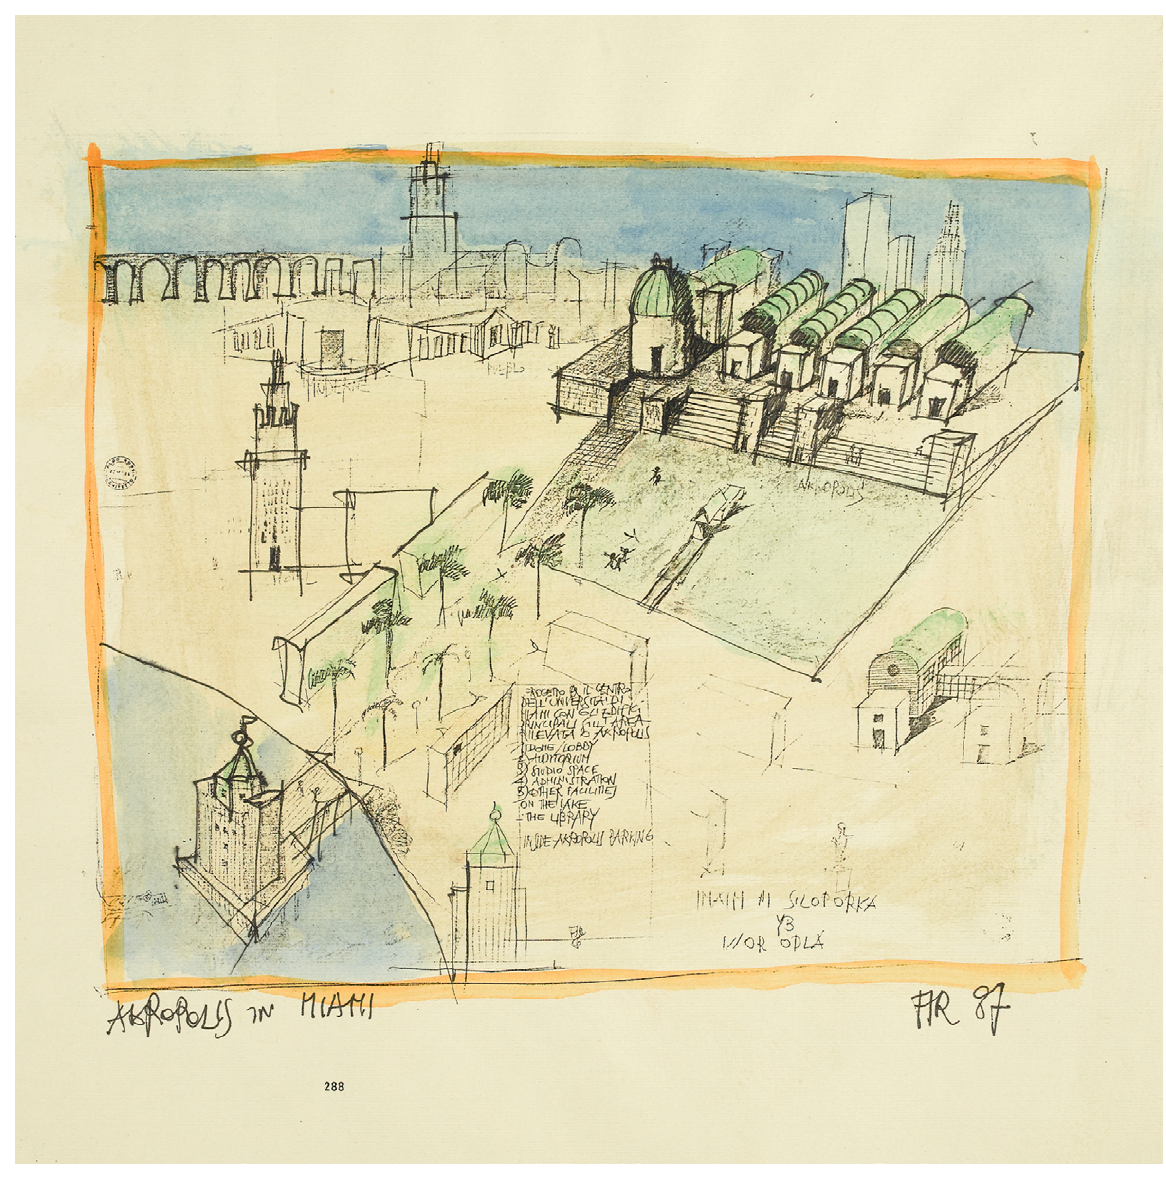
AKROPOLIS IN MIAMI, Aldo Rossi, 1987, ©Eredi Aldo Rossi, courtesy Fondazione Aldo